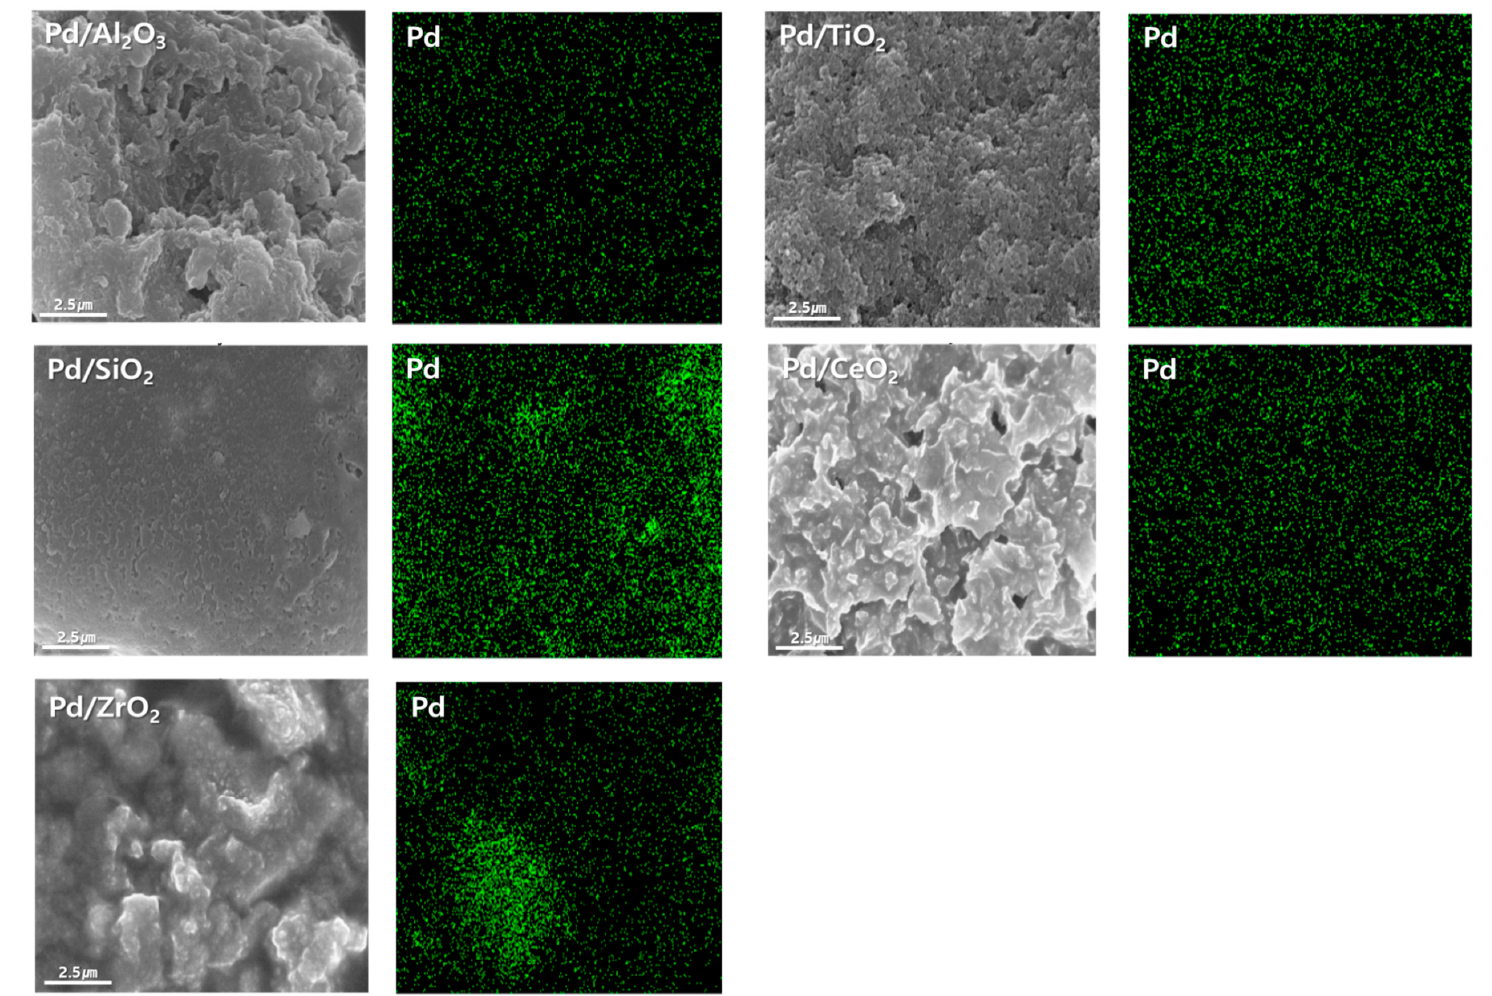
Figure 7. FE-SEM images and EDX spectra of Pd catalysts.